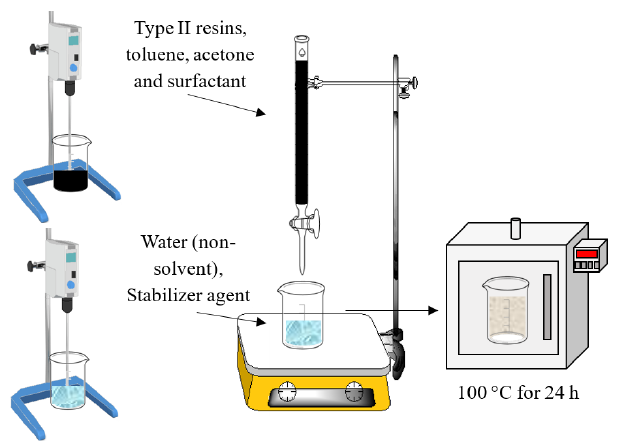
Figure 12. Experimental setup employed for the synthesis of nanocapsules of Span 20 and Petro 50 surfactants in vacuum residue-isolated type II